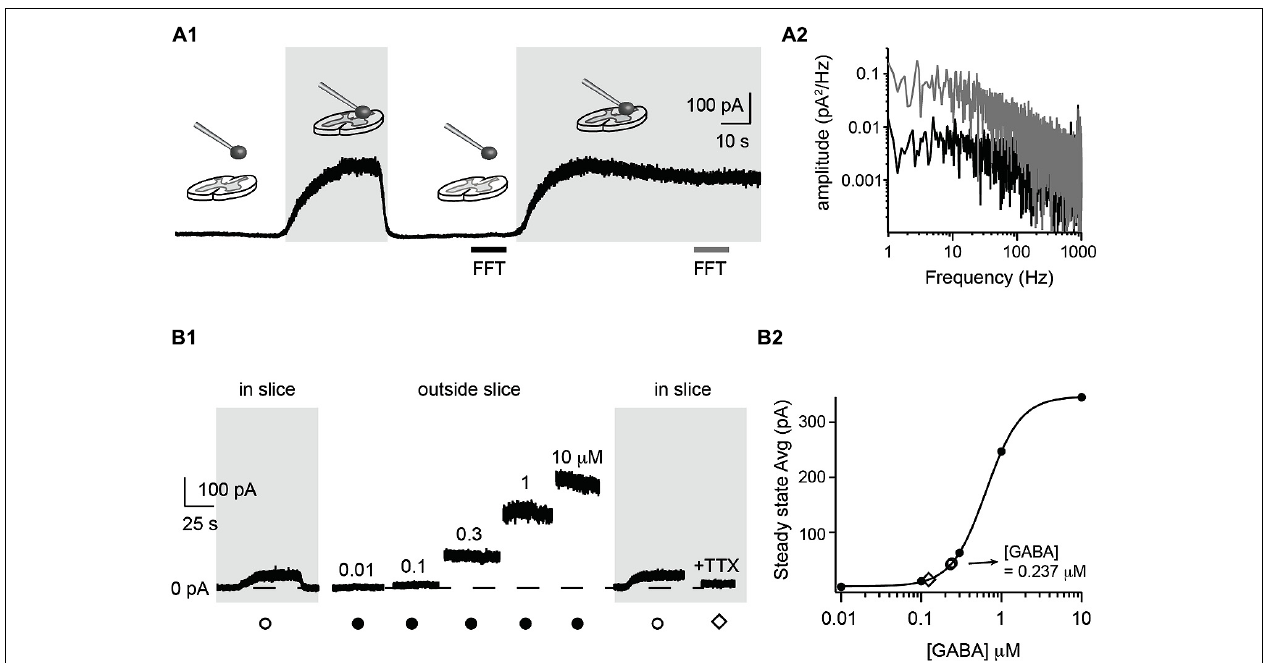
FIGURE 3 | Detection and quantification of ambient GABA in a slice preparation. (A1) Response of a sniffer at different positions above a slice preparation from the spinal cord. Positioning the sniffer at the slice surface evoked a persistent outward current and increased the noise of the recording. Both current and noise disappeared when the sniffer was moved 500 μ m above the slice. The gray and black horizontal bars indicate the time intervals used for Fast Fourier Transformation (FFT) analysis in A2 . (A2) Power spectrum densities of the current measured by the sniffer far from the slice (black) and on the surface (gray). The frequencies between 1 and 1000 Hz were stronger when the sniffer was just above the surface of